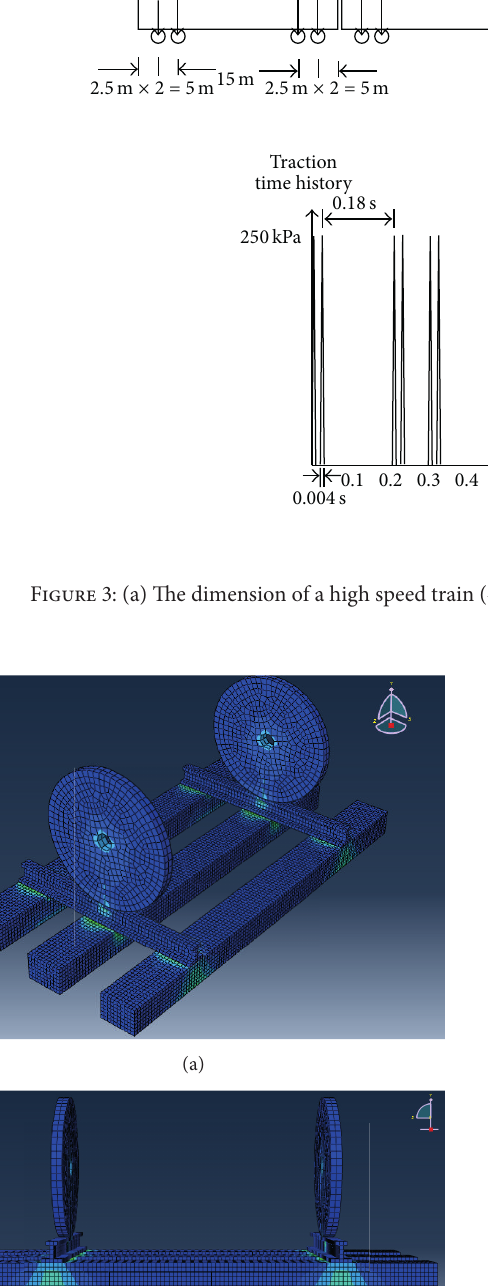
the wheel loading is applied on the elastic sleepers or rail.